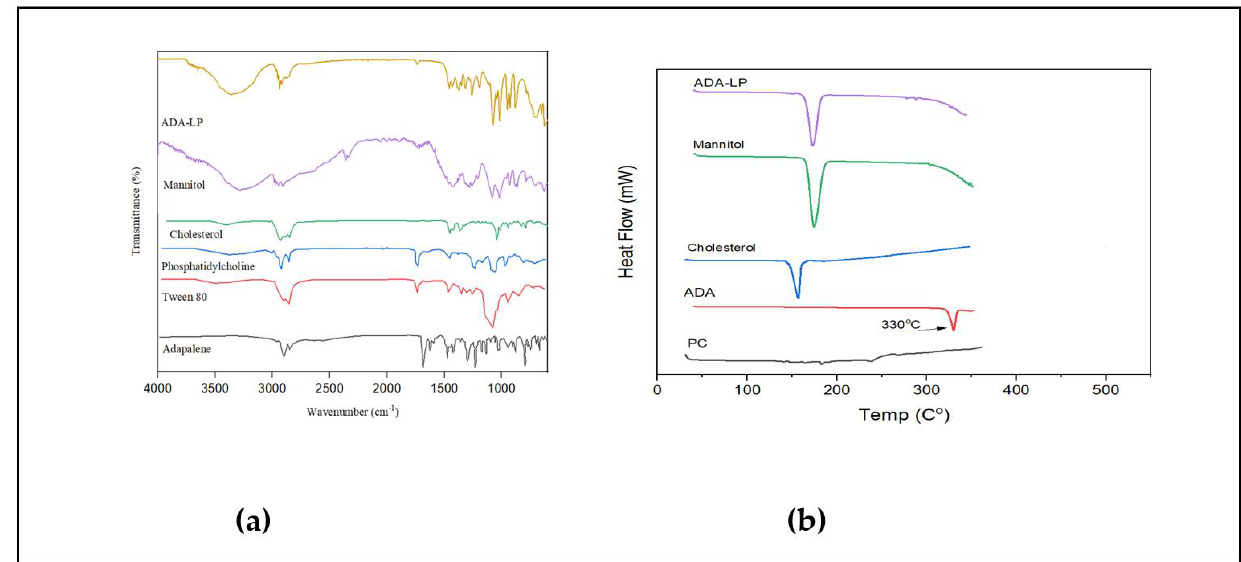
Figure 3. ( a ) FTIR and ( b ) DSC of excipients, drug and prepared ADA-LP.